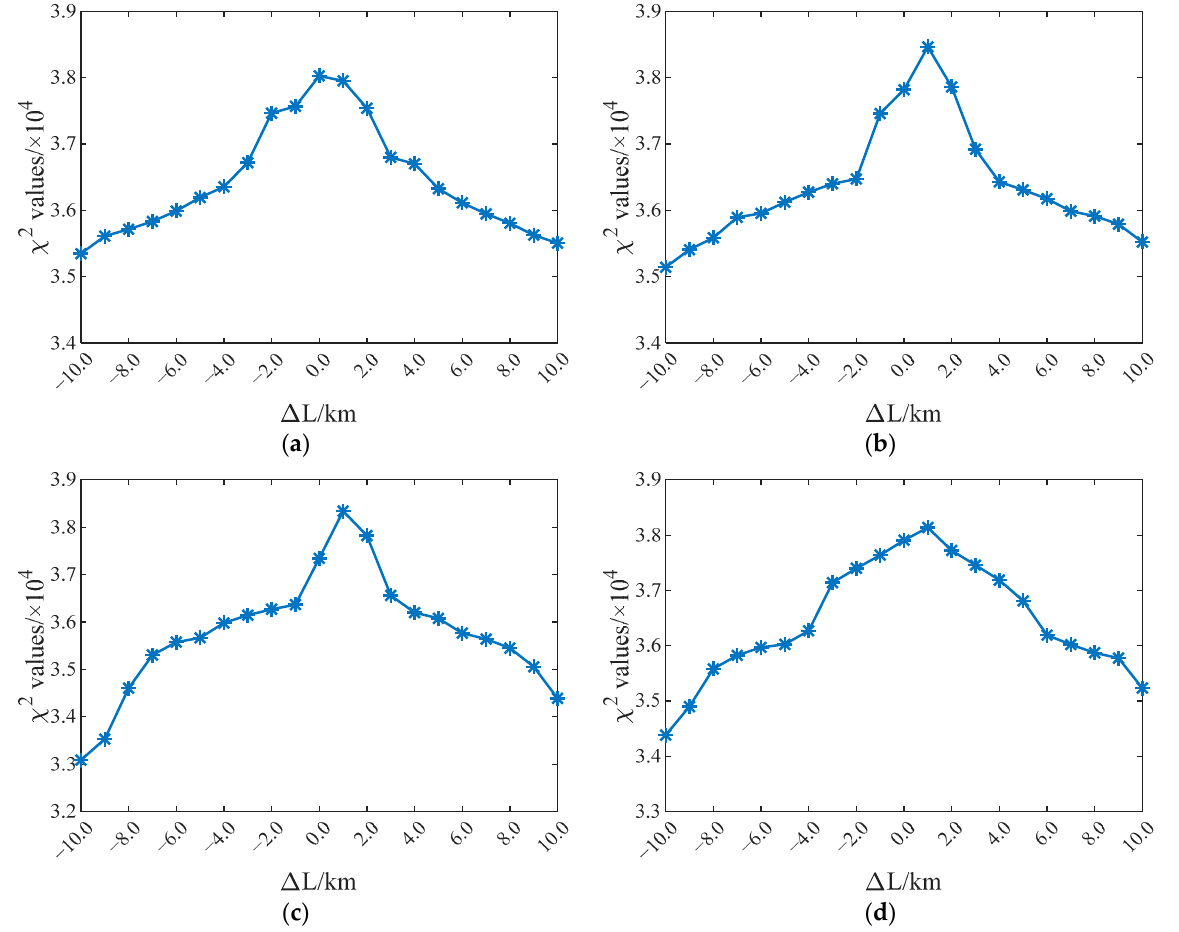
Figure 7. Comparison of chi-square values of each ephemeris simulation orbit. ( a ) DE200; ( b ) DE405; ( c ) DE421; ( d ) DE430. Table 6. χ 2 values of each ephemeris simulation orbit.